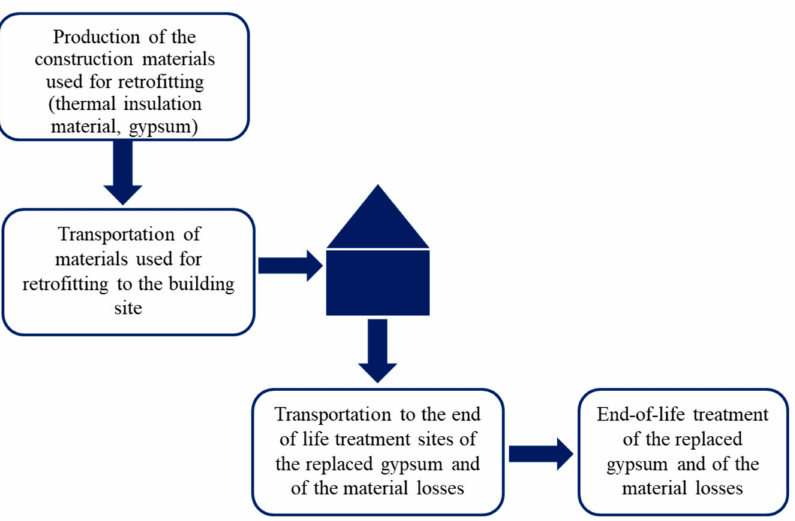
Figure 2. System boundary for FU R —retrofit